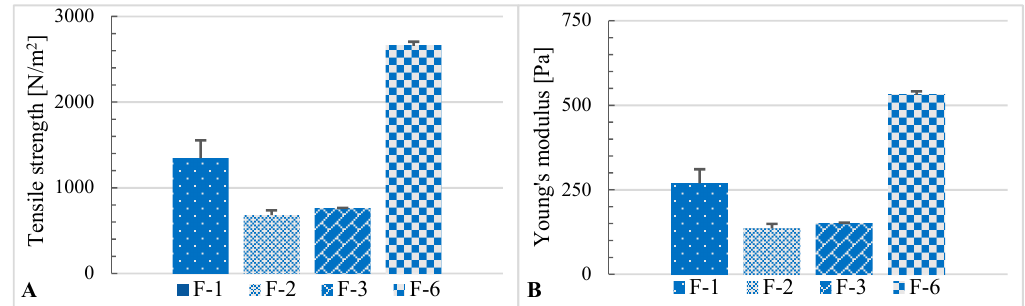
Figure 6. Comparison of: ( A )—tensile strength profiles for control selected ointments with ACTH (F-3 and F-6) and unloaded bases: F-1 as a F control and F-2 (with 1 mol / L acetic acid solution—10%); ( B )—Young’s modulus for control selected ointments with ACTH (F-3 and F-6) and unloaded bases: F-1 as a F control and F-2 (with 1 mol / L acetic acid solution—10%).